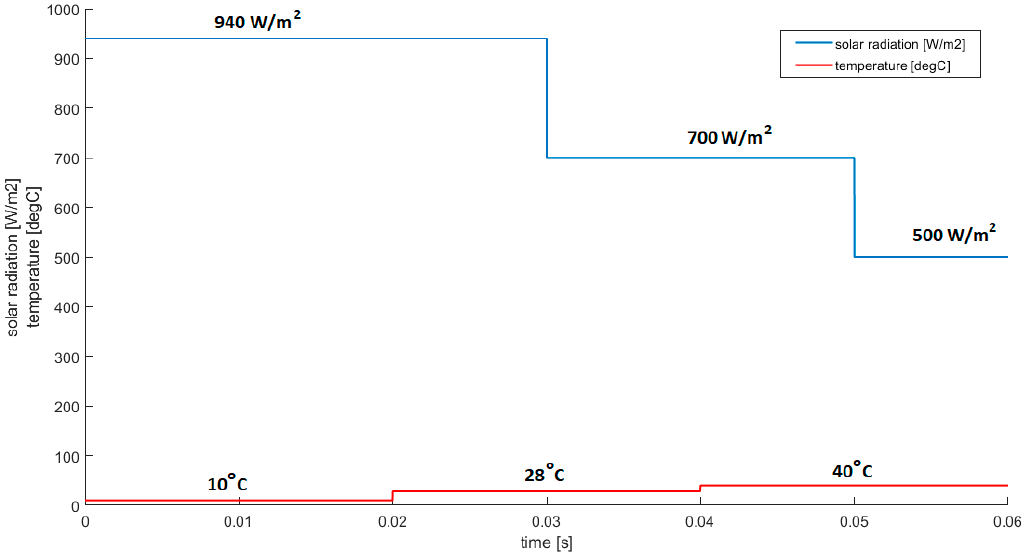
Figure 9. Dynamic of the solar radiation and temperature over time.